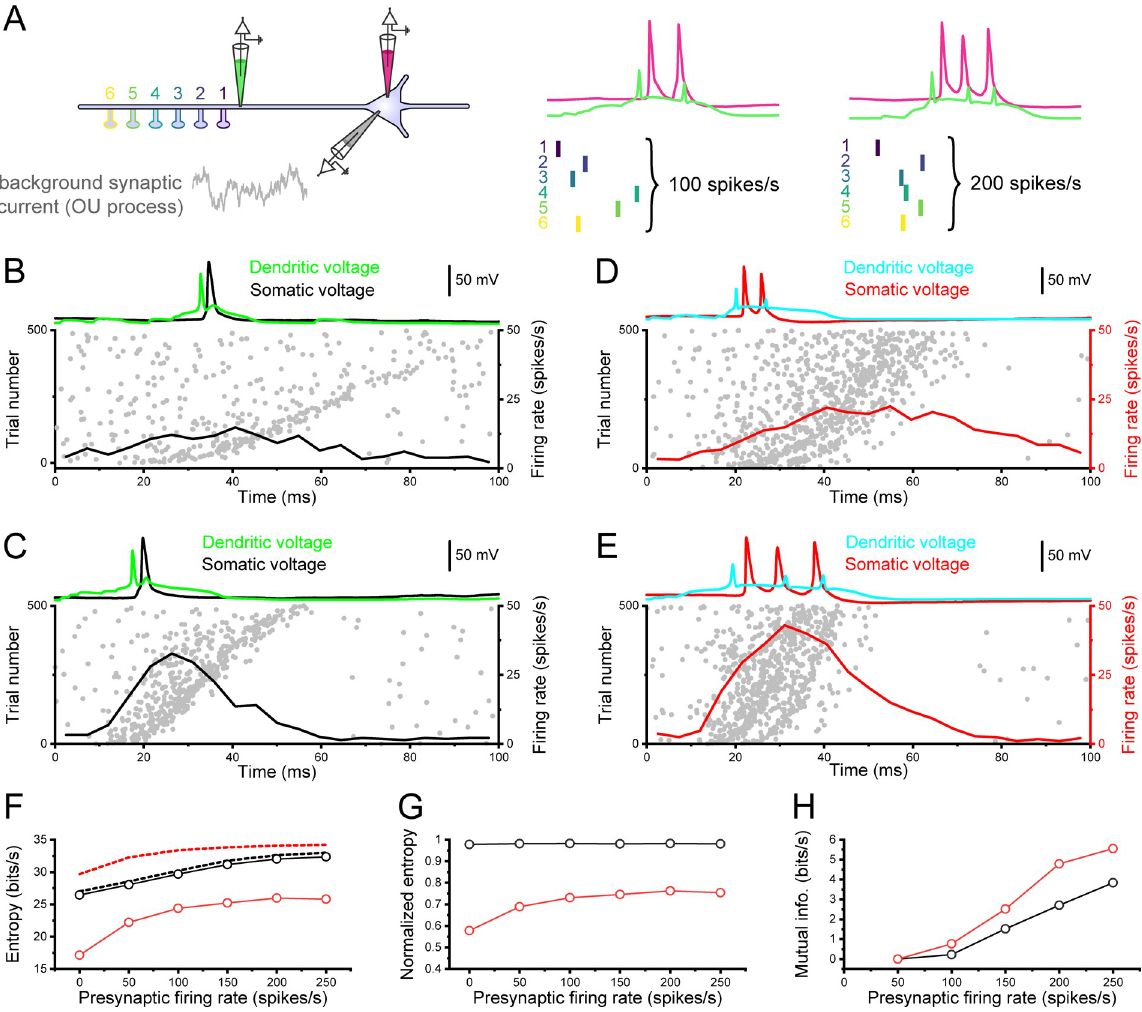
Fig 7. Firing patterns of a-thorny cells encode more information about the statistics of presynaptic inputs. (A) Schematic of the experimental design: left, six spines are placed on the apical dendrite of a cell that is simultaneously stimulated by the somatic injection of an OU process mimicking the arrival of a large number of asynchronous inputs impinging on the dendritic tree. The magenta and green pipettes represent the somatic and dendritic recording locations, respectively. Right, example somatic and dendritic Vm traces in response to a volley of presynaptic spikes arriving at 100 or 200 spikes/s. (B) Spiking dynamics of a thorny cell in response to the injection of both a noisy current at the soma, mimicking the arrival of a large number of presynaptic inputs, and of 6 additional dendritic inputs whose inter-stimulus intervals are distributed according to a Poisson distribution at a rate of 100 spike/s. Each dot in the raster plot represents one postsynaptic AP and each row shows the APs emitted by the cell in response to the arrival of one presynaptic burst, with time being aligned to the arrival of the first presynaptic AP in the burst. Trials are ordered according to the duration of the presynaptic bursts, with shorter bursts having lower trial numbers. The top trace shows the dendritic and somatic Vm in response to the arrival of one presynaptic burst. The black trace represents the firing rate of the thorny cells computed over all trials. (C) Same as (B), but for presynaptic bursts arriving at a mean firing rate of 200 spike/s. (D, E) Same as (B, C), but for an a-thorny cell. Notice how this cell type preferentially responds with bursts as the presynaptic firing rate increases. (F) Entropy of the post-synaptic spike train for thorny and a-thorny cells (black and red markers, respectively) as a function of the presynaptic intra-burst firing rate. The black and red dashed lines represent the theoretically maximal entropy achievable by a point process at the same firing rate as that of the corresponding cell type. (G) Same data as shown in (F) but normalized to the maximal achievable entropy. (H) Mutual information between the postsynaptic firing times and the presynaptic burst times (i.e., the time of the first AP in the presynaptic burst), as a function of the presynaptic intra-burst firing